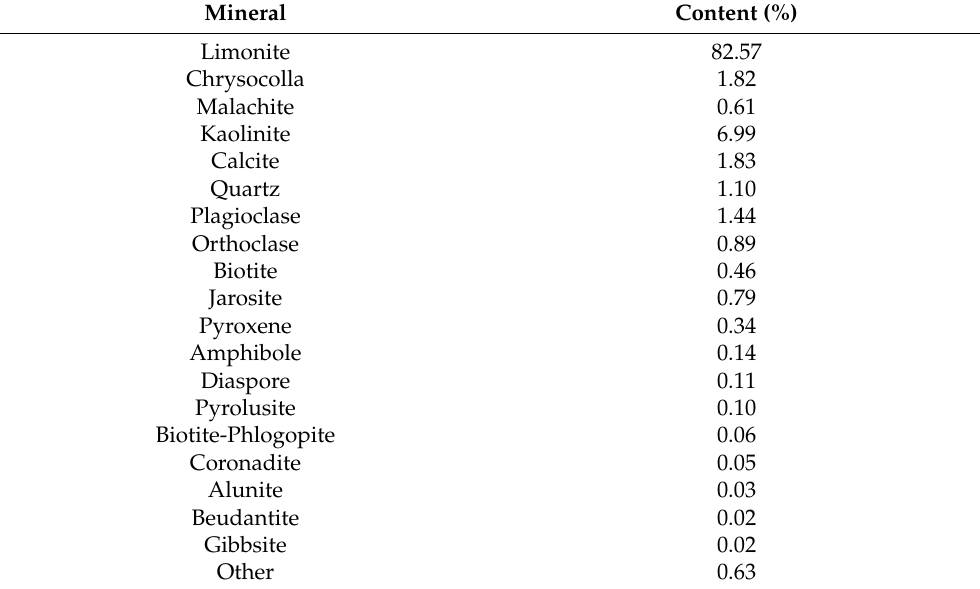
Table 2. Mineral composition of COBL